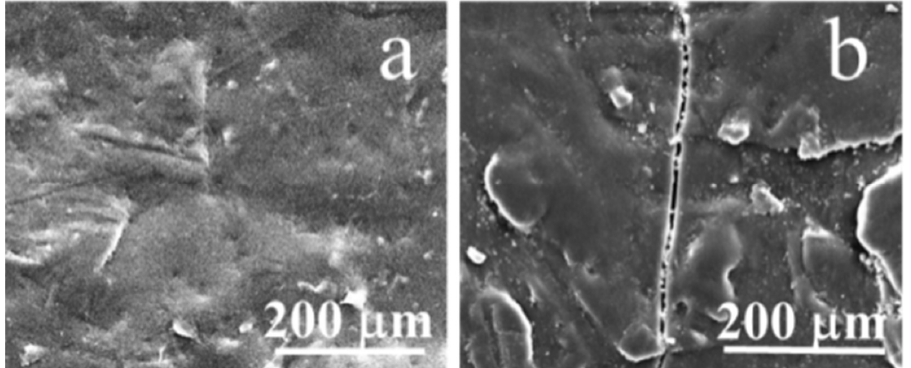
Figure 3. Surface topography of CF/PC composites. ( a ) un-aged composites surface, ( b ) hydrothermal aged for 42 days surface of CF/PC composites. 80 °C.